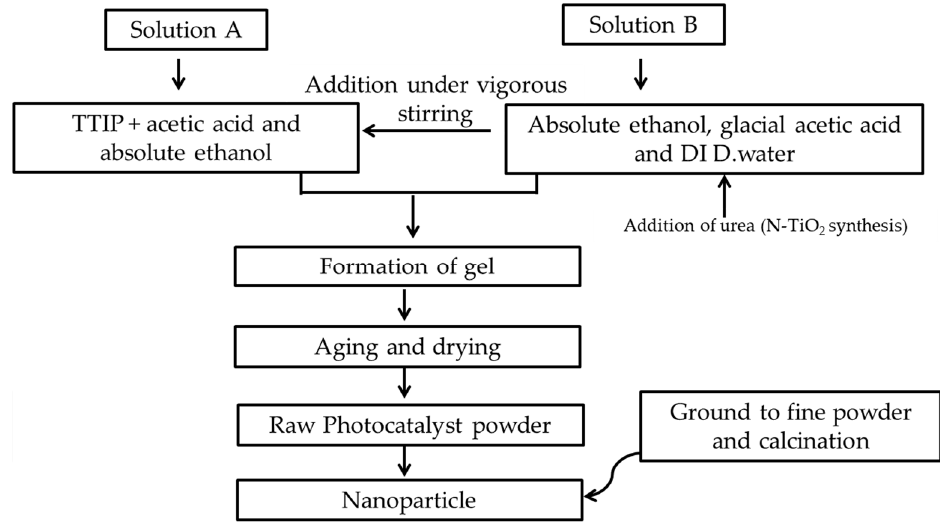
Figure 20. Flow diagram of photocatalyst synthesis.